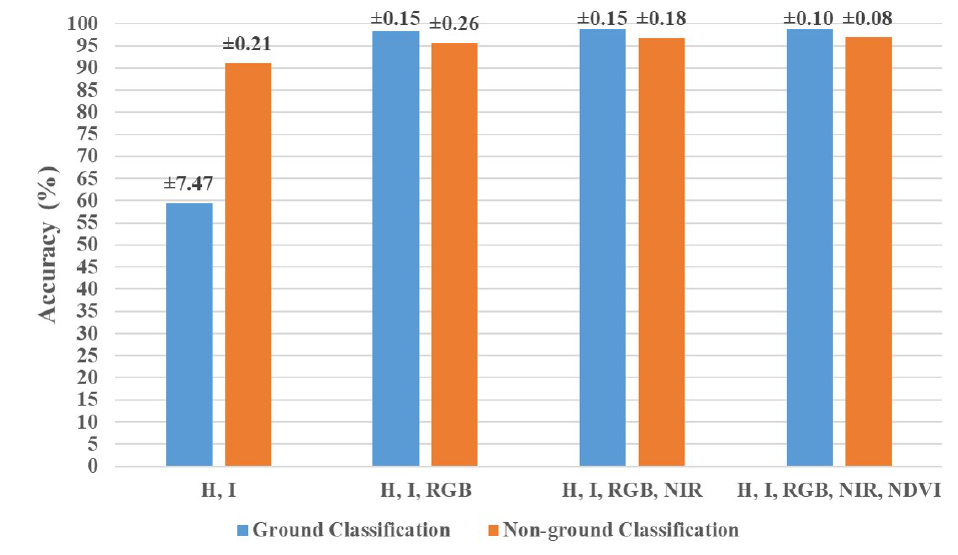
Figure 13. K -fold cross-validation results of MLP neural network